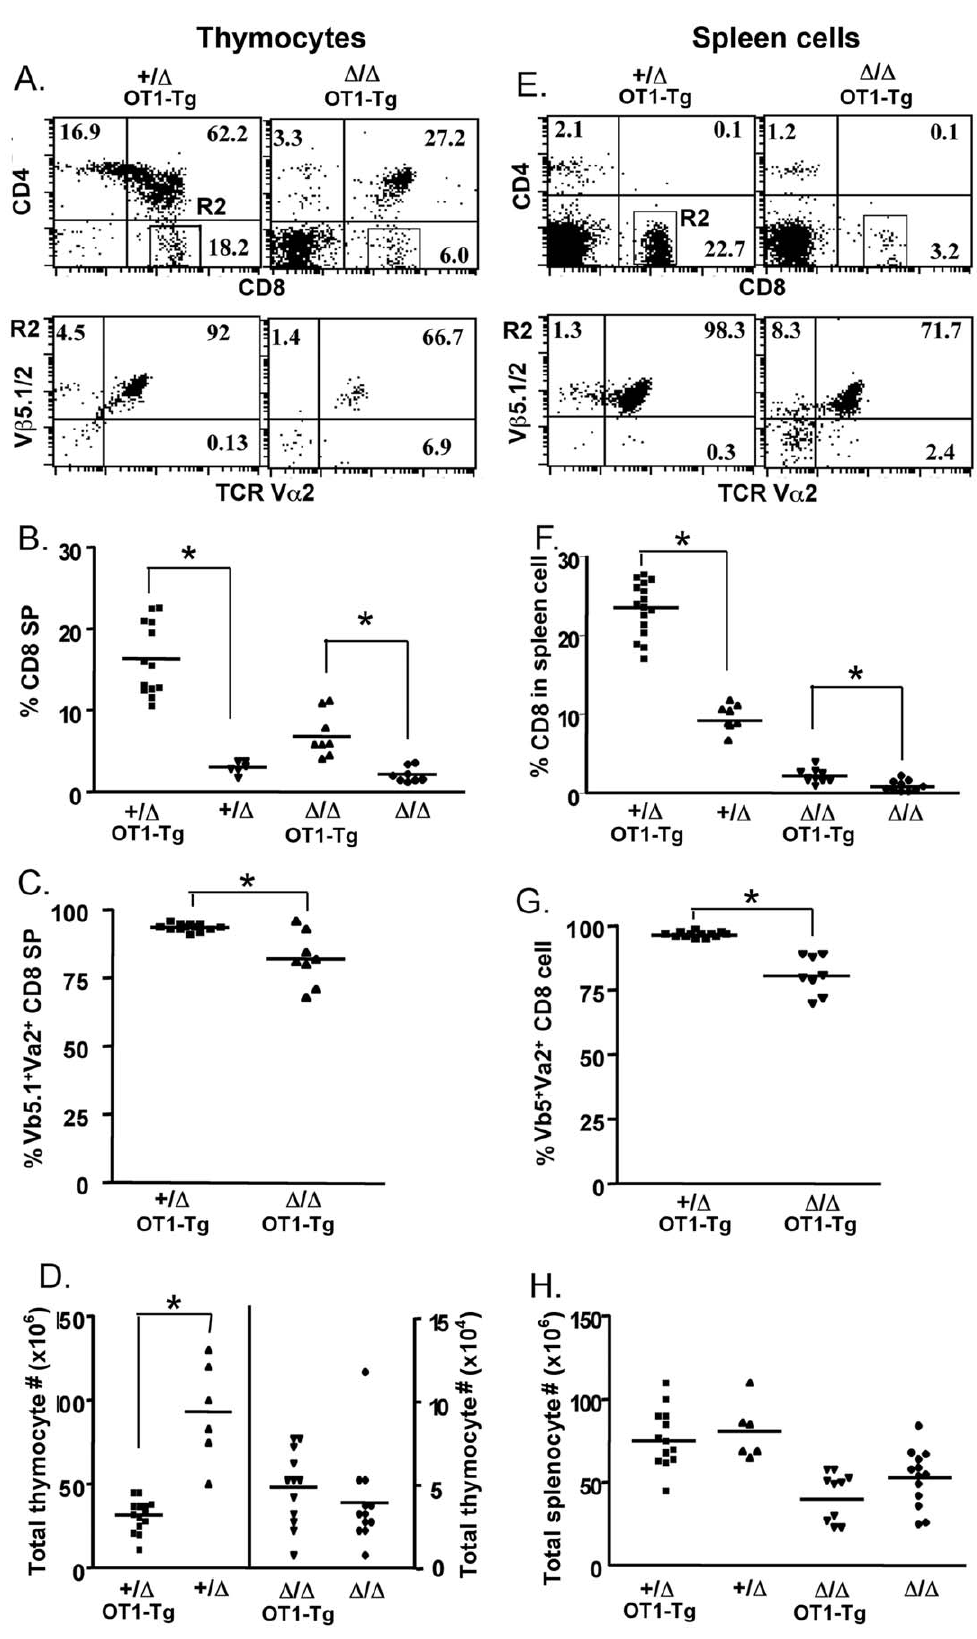
Figure 4. Positive selection for CD8 Tg T cells was partially reduced in Foxn1 D / D mice. Foxn1 D / D ;OT1 and Foxn1 D / D ;OT1 Tg mice were generated by mating Foxn1 D / D mice with OT1 CD8 TCR Tg mice, and the CD8 Tg cells were analyzed in thymocytes (A, B, C and D) and splenocytes (E,